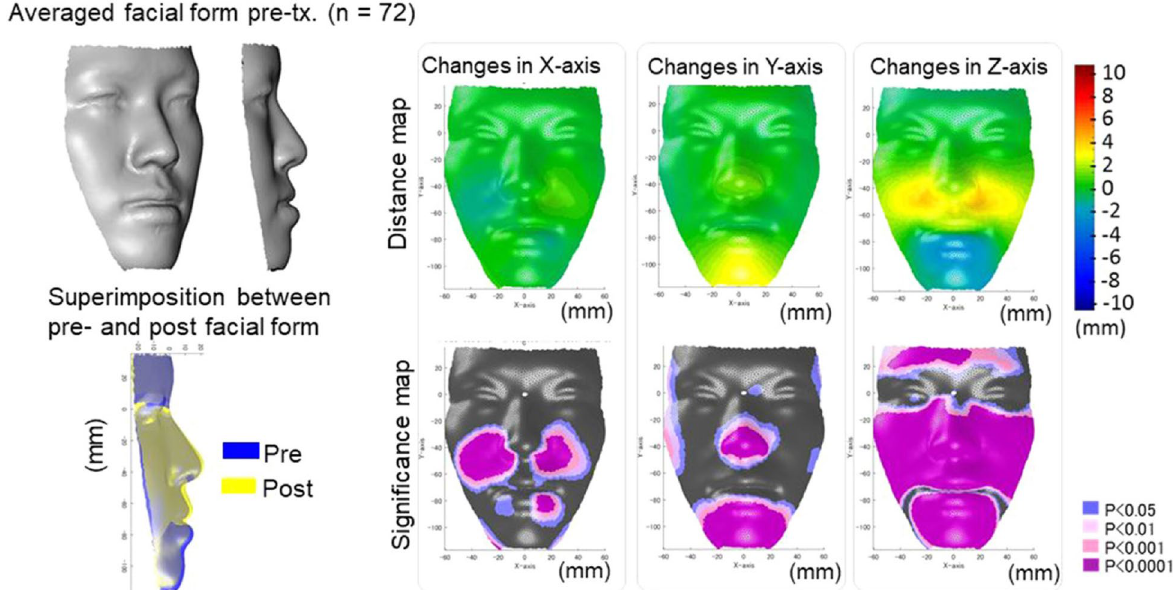
Fig. 3 In a study by Tanikawa et al., facial morphology in Japanese patients after orthognathic surgery and orthodontic treatment was predicted using AI [2]. Surgery group pre-treatment actual facial changes (top-left) and the superimposition of pre-treatment and post-treatment actual facial changes (blue and yellow). After surgery, the blue column indicates a downward displacement after treatment, and the yellow column indicates an upward displacement after treatment. When viewed antero-posteriorly, yellow indicates protrusion, while blue indicates retrusion. A custom MATLAB program was used to create the